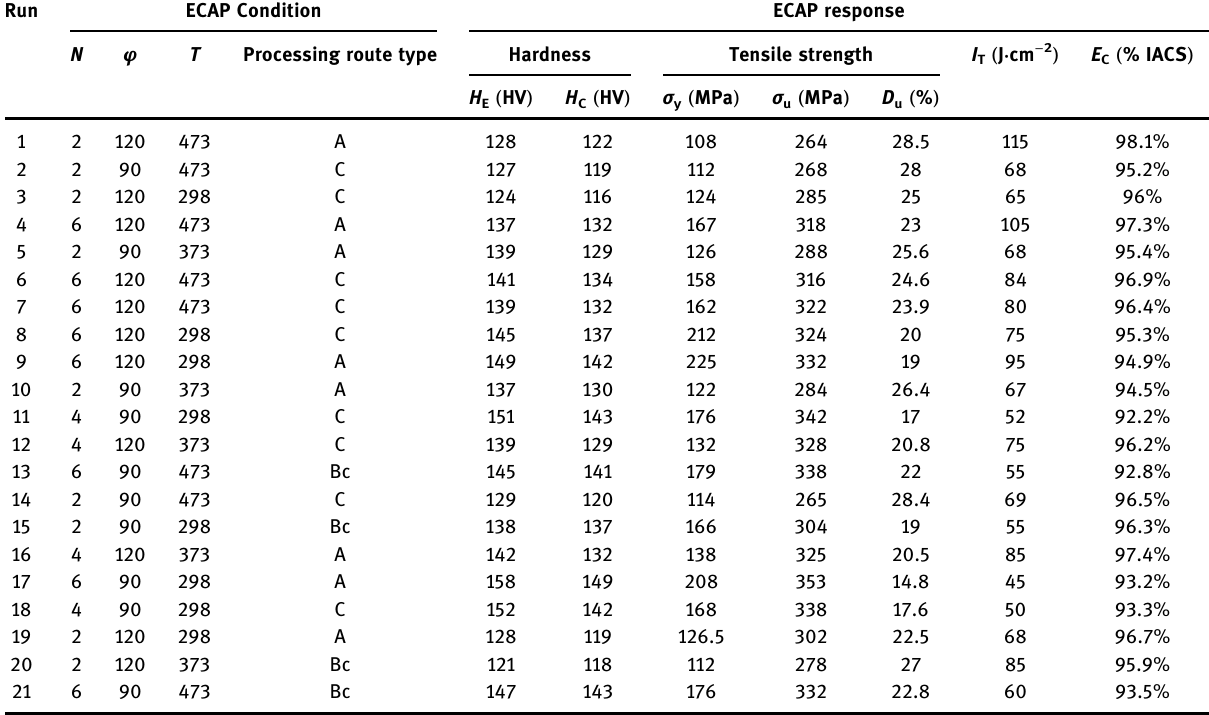
Table A1: Design of experiment of ECAP parameters and process